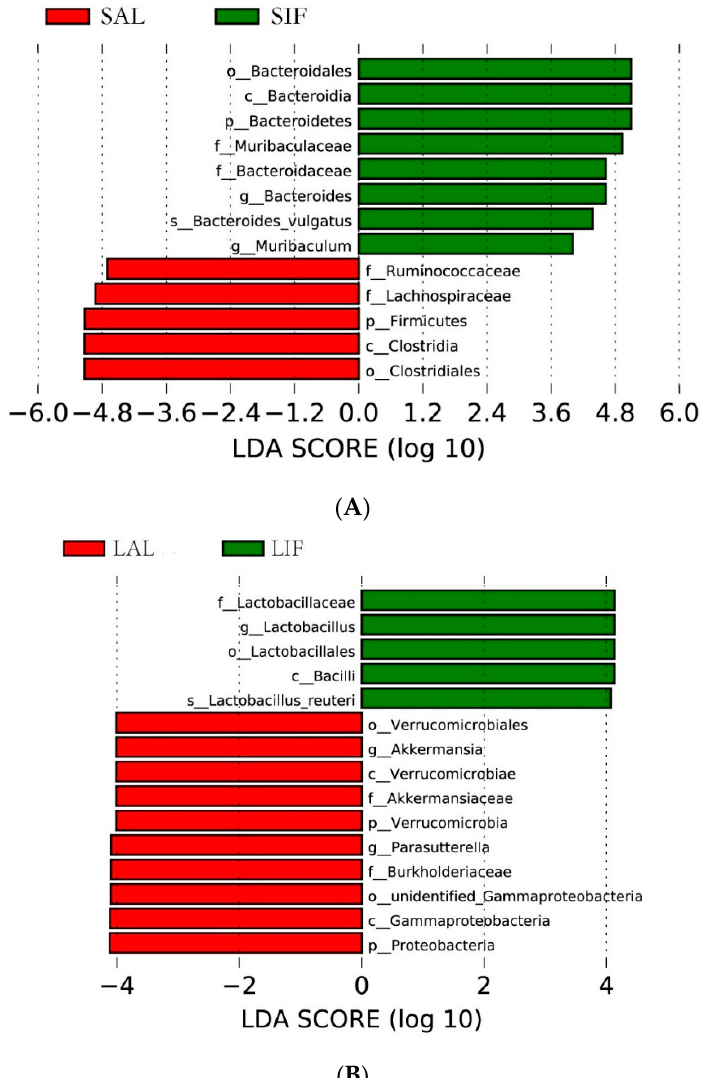
Figure 2. Discriminative biomarkers identified in the populations after IF : ( A ) discriminative biomarkers with an LDA score of > 4 in the SAL and SIF groups; and ( B ) discriminative biomarkers with an LDA score of > 4 in the LAL and LIF groups. SAL: Short-term of ad libitum-fed group; SIF: Short-term of intermittent fasting group; LAL: Long-term of ad libitum-fed group; LIF: Long-term of intermittent fasting group.